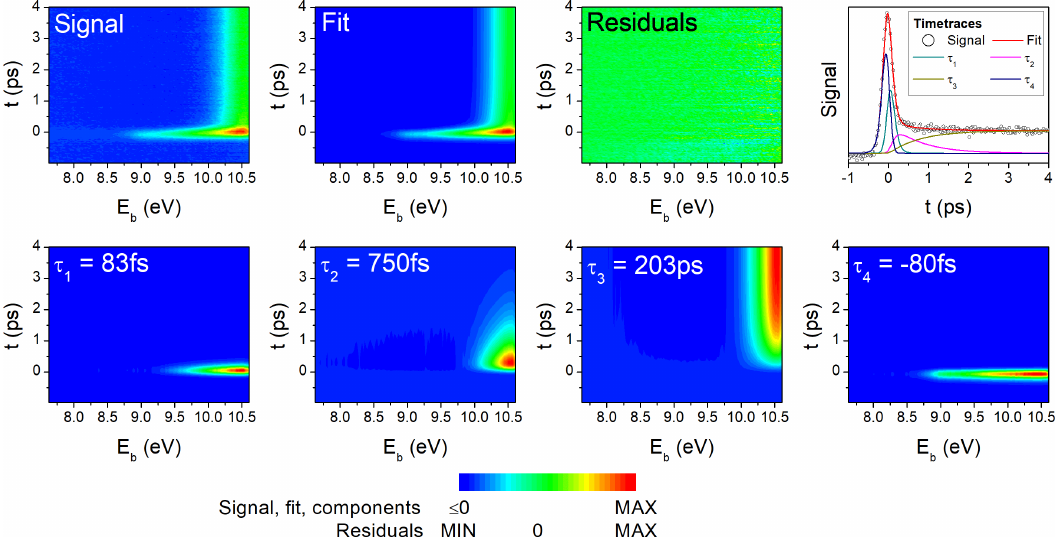
Figure 1. 2D time-resolved photo-electron spectrum of 2-thiouracil recorded with 293 nm excitation and 194 nm one-photon ionization ( top row, first column ). Individual contributions to the 2D spectrum from global analysis techniques are plotted in the bottom row. Summation of these contributions yields the total fit ( top row, second column ) and when subtracted from the signal results in the residuals ( top row, third column ). All 2D spectra are plotted as color maps with the pump-probe delay, t (ps), along the y -axis and the electron binding energy, E b (eV), along the x -axis; signal intensities are represented according to the color bar on the bottom. The time traces ( top row, fourth column ) correspond to the signal, fit, and individual contributions integrated over all electron binding energies. Background subtraction errors in the probe-pump region amount to 3% of the maximum